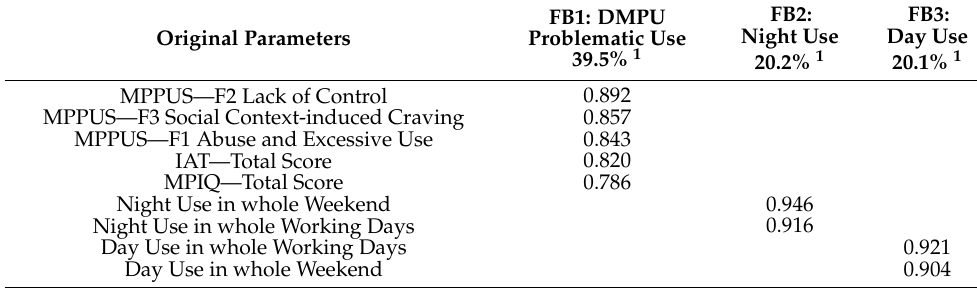
Table 9. Factorial analysis of variables used to assess behavior associated with DMPU.